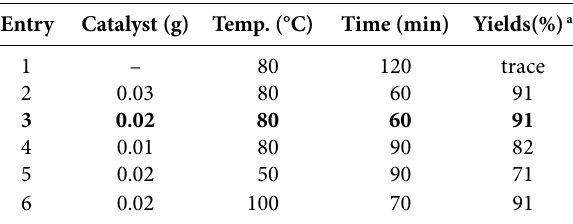
Table 1. The Effect of the catalyst amount and temperature on the model